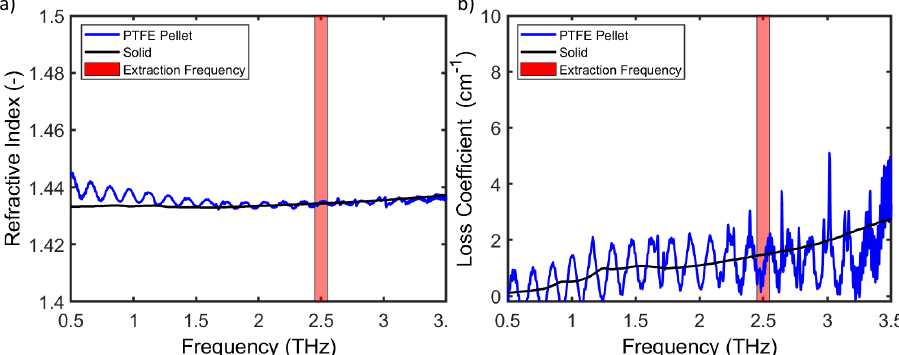
Figure 1. Refractive index ( a ) and loss coefficient ( b ) spectra of PTFE pellets. Oscillations in spectra are artifacts due to internal